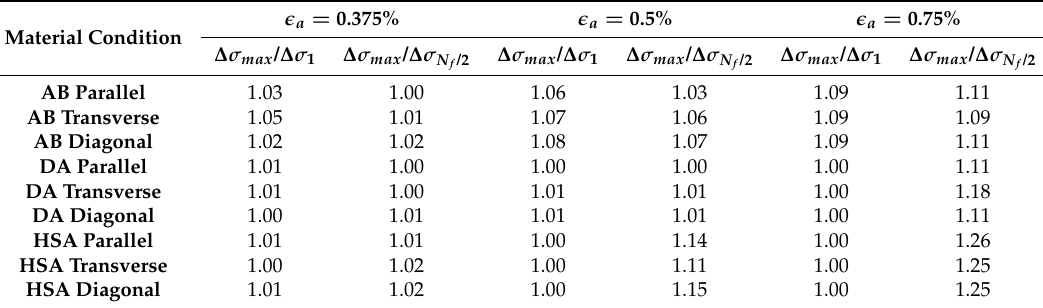
Figure 11. Stress evolution of transverse specimens in different post-treatments at ( a ) (cid:101) a = 0.3% and ( b ) (cid:101) a = 0.75%. Table 5. Cyclic stress evolution behaviour of different material